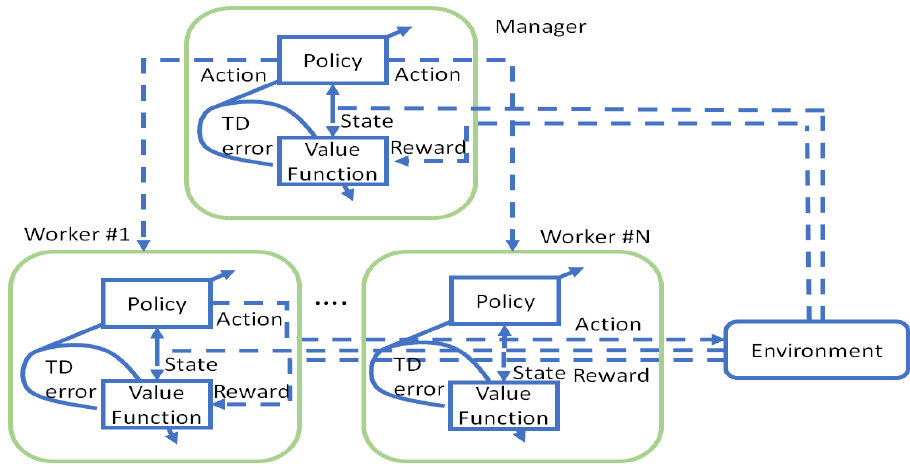
Figure 1. Hierarchical DDPG architecture .